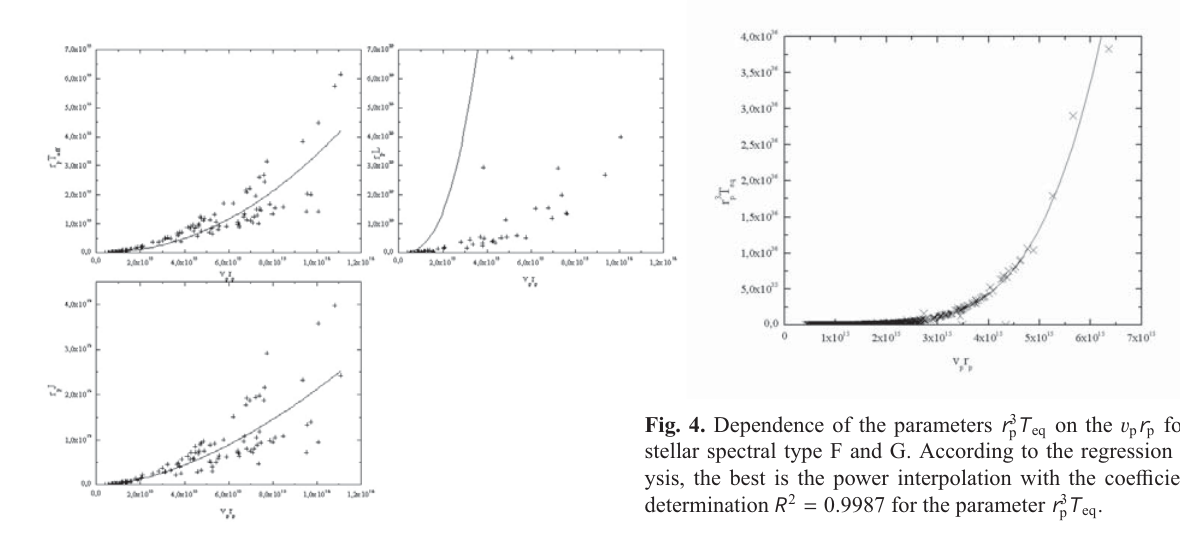
T eq on the v p r p for the p T eq p